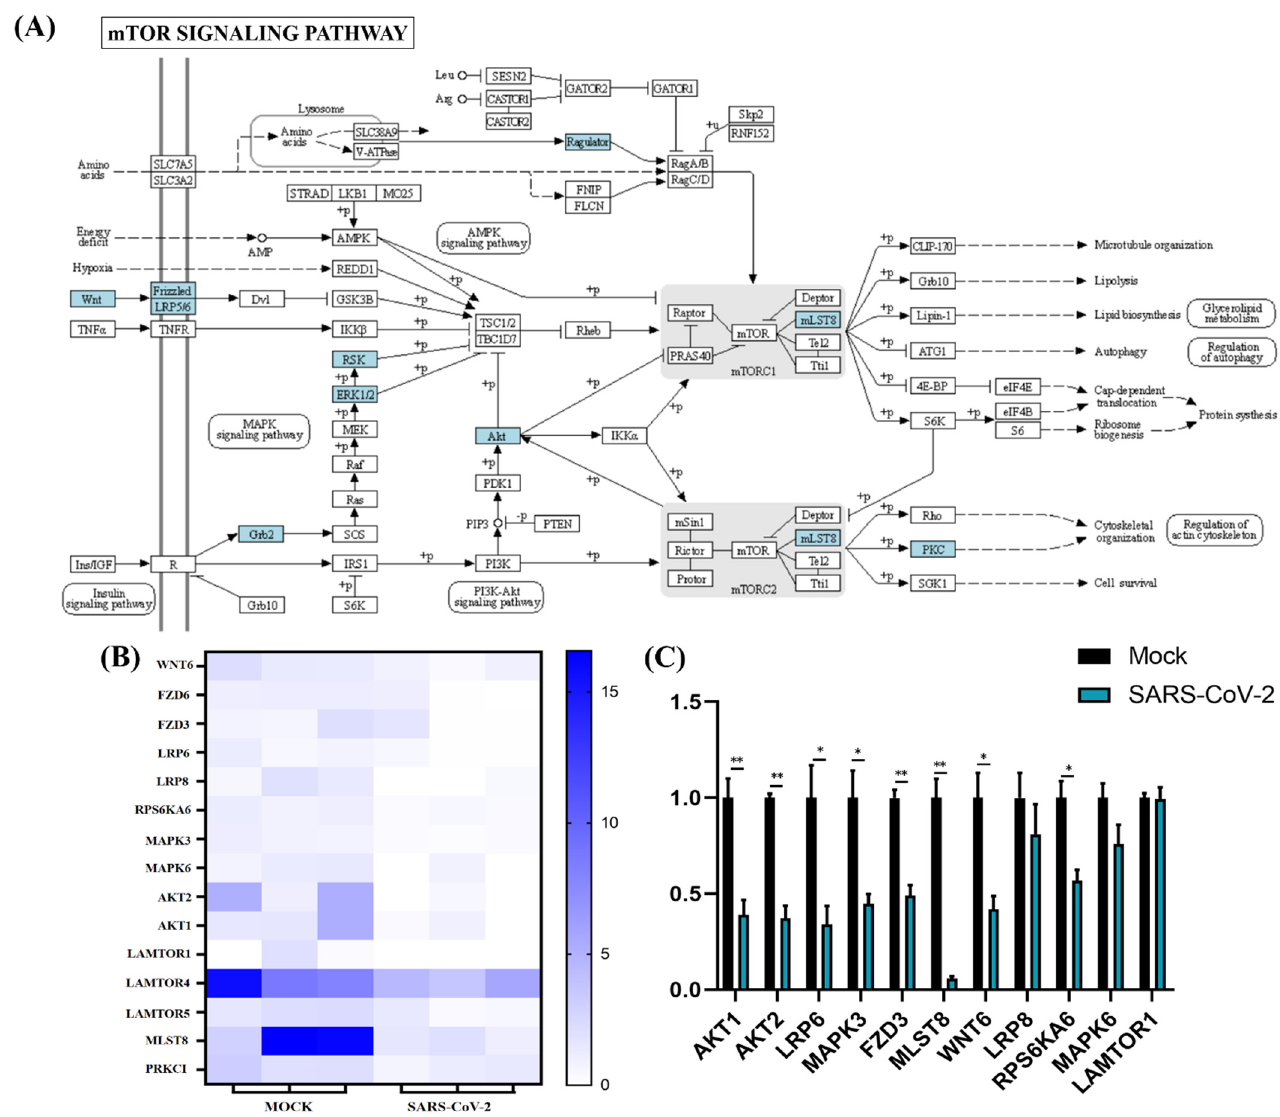
Figure 7. mTOR signaling pathway analysis of SARS-CoV-2 alone induced downregulated genes. ( A ) SARS-CoV-2 infection could regulate the mTOR pathway. The key downregulated genes are marked in blue. ( B ) Expression pattern of downregulated genes involved in mTOR signaling path- ways. ( C ) Relative RNA expression quantified by qRT-PCR, n = 3. “*” represents p < 0.05 and “**” represents p < 0.01.